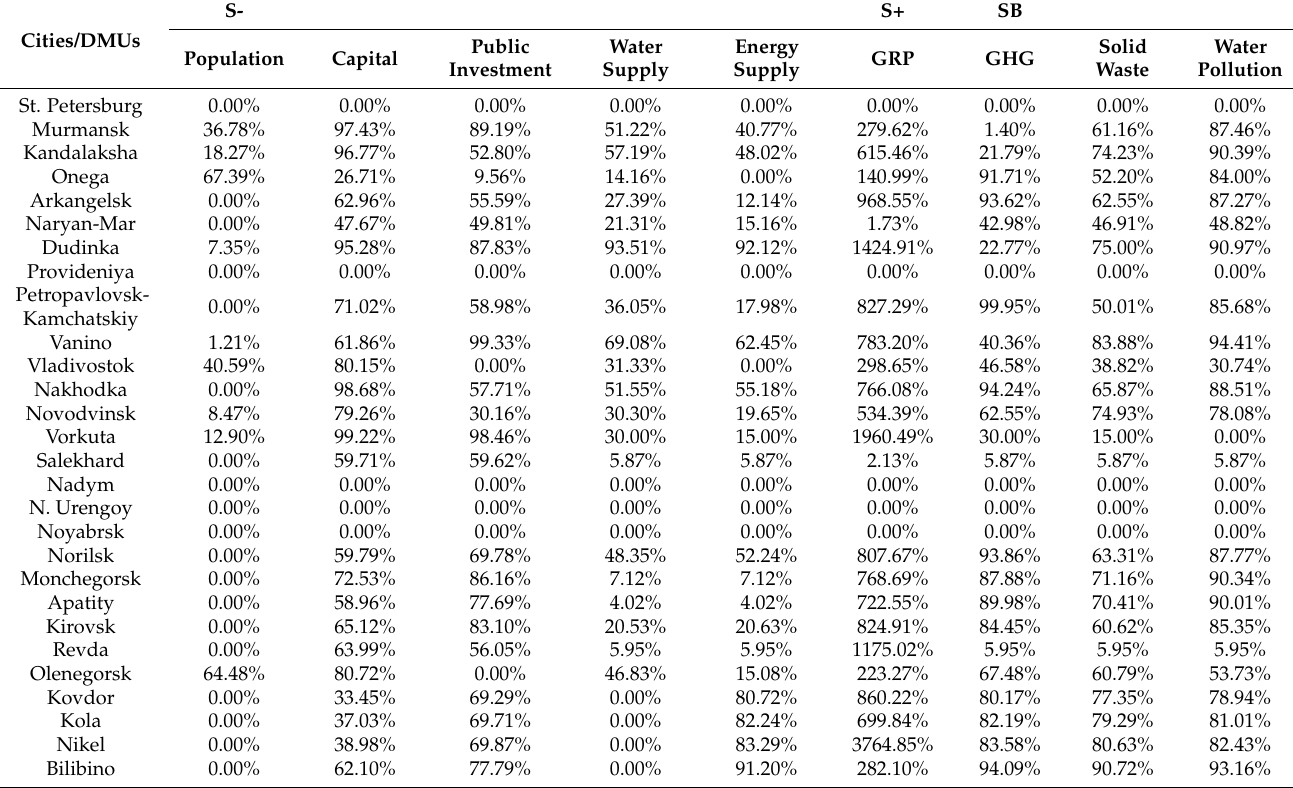
Table 4. The average annual percentage change of input and output variables for the Russian cities along the NSR.